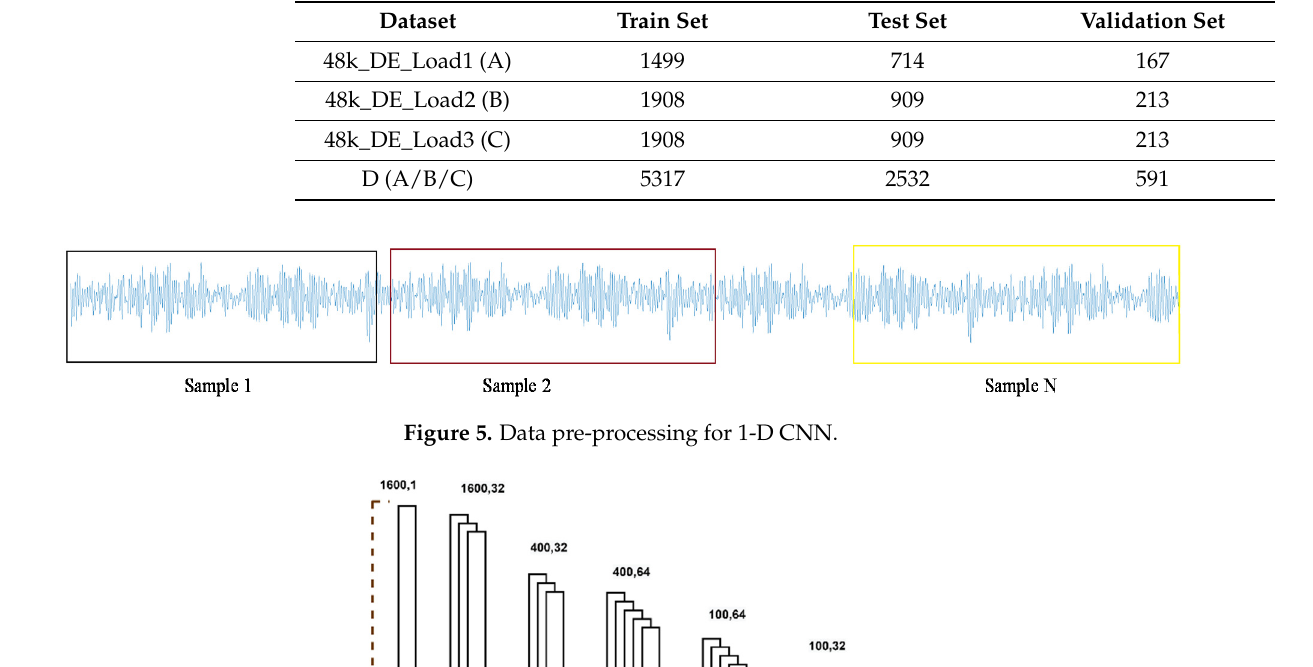
Table 2. Length of train, test, and validation set used in the research.